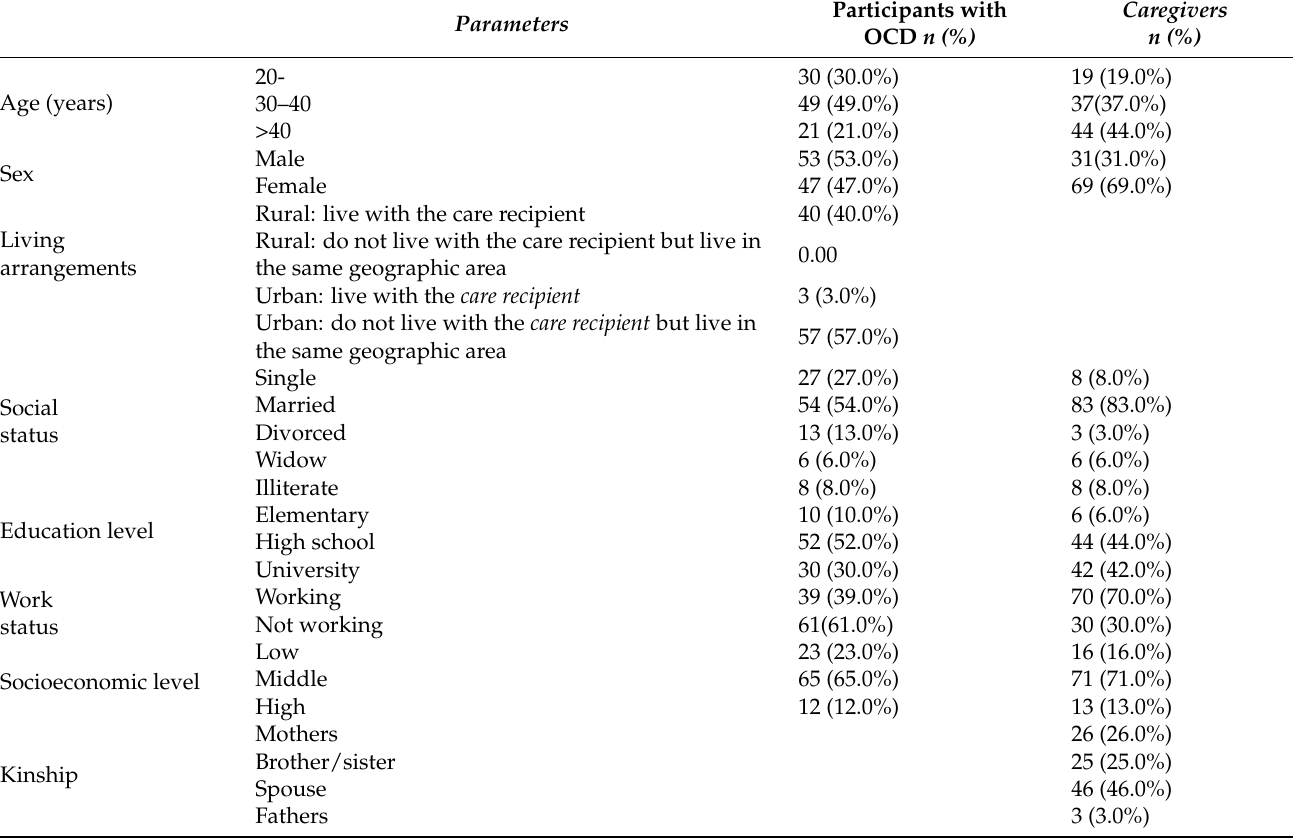
Table 1. Demographic characteristics of participants with OCD and